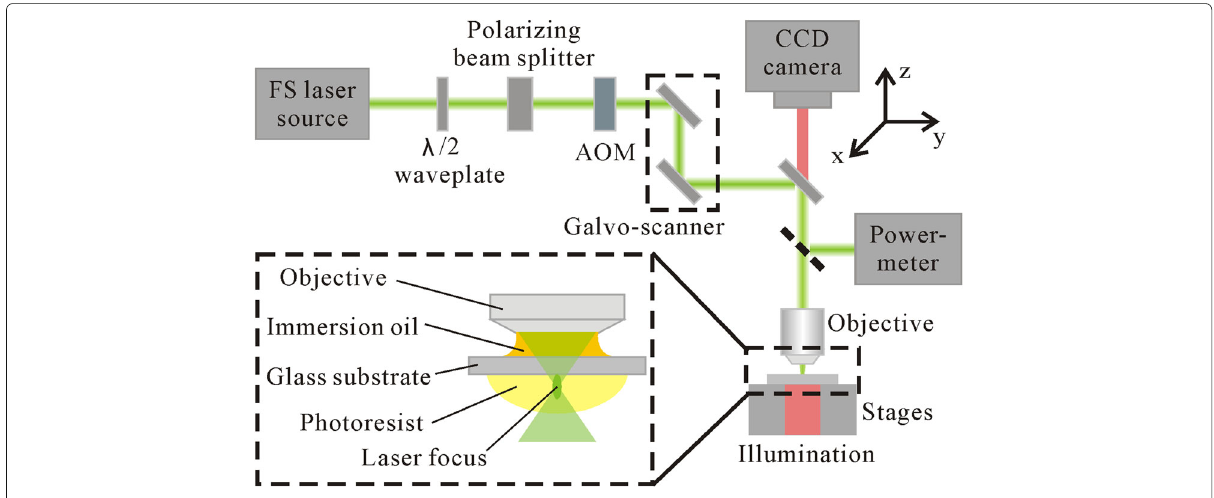
Fig. 2 Schematic diagram of 2PP fabrication system